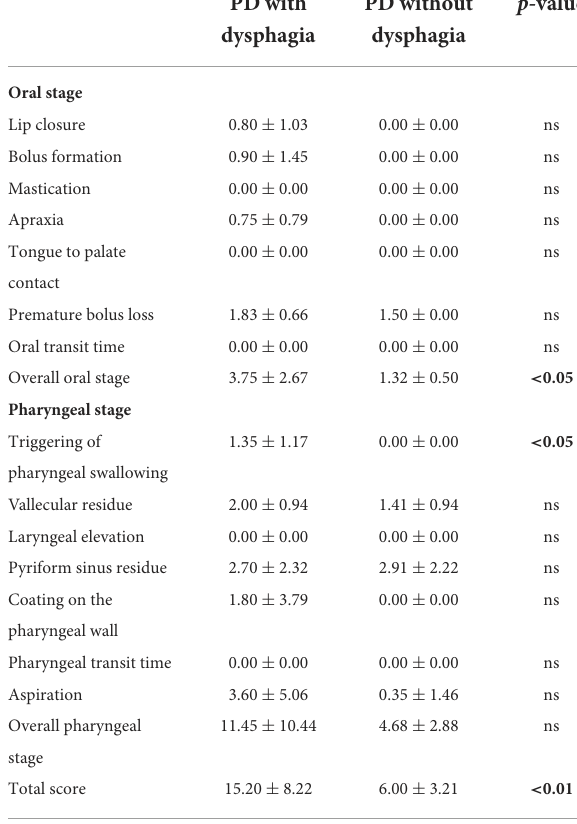
TABLE 3 Comparison of each subitem in the oral and pharyngeal stages obtained by a videofluoroscopic swallowing study (VFSS) between the PD with dysphagia and PD without dysphagia